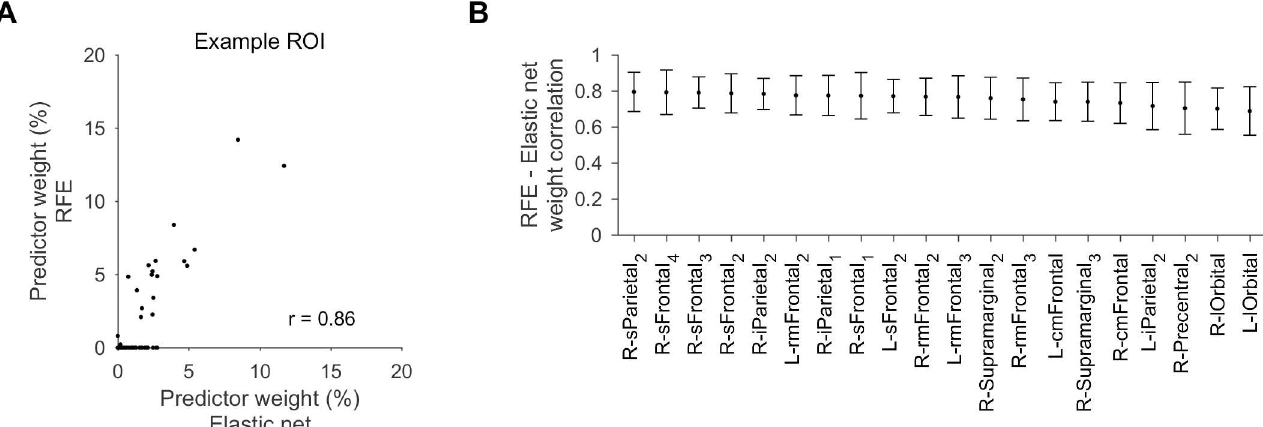
Fig 6. Predictor weights in RFE and elastic net models are strongly correlated. A. Predictor ROI weights for models of right inferior parietal cortex 2 of an examplesubject, derived using either RFE or elastic net, were strongly correlated ( r = 0.86, p < 10 − 38 ). B. Correlation between predictor ROI weights derived using RFE or elastic net for the 20 ROIs with large multiregionalprediction